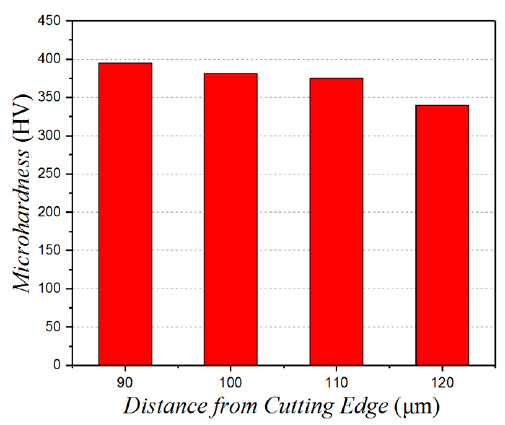
Figure 14. The effect of the micro ‐ pits distance from cutting edge on the micro ‐ hardness.